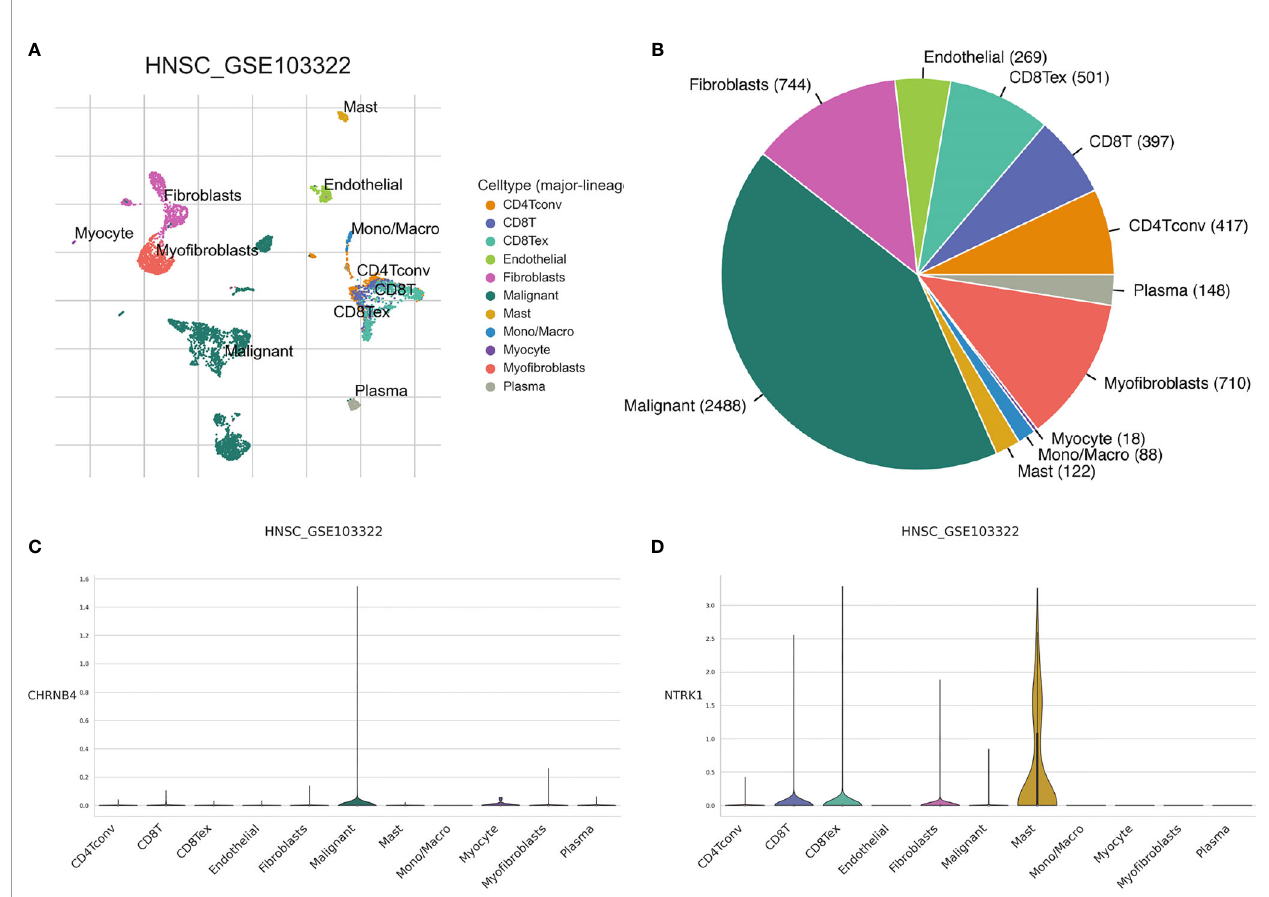
FIGURE 9 | The expression of seven prognostic NCCGs in the tumor microenvironment of HNSC. (A, B) Cell types in HNSC single-cell sequencing data set GSE103322. (C) Average expression of CHRNB4 in different kinds of cells. (D) Average expression of NTRK1 in different kinds of cells. NCCGs, nerve-cancer cross- talk genes; HNSC, head and neck squamous cell